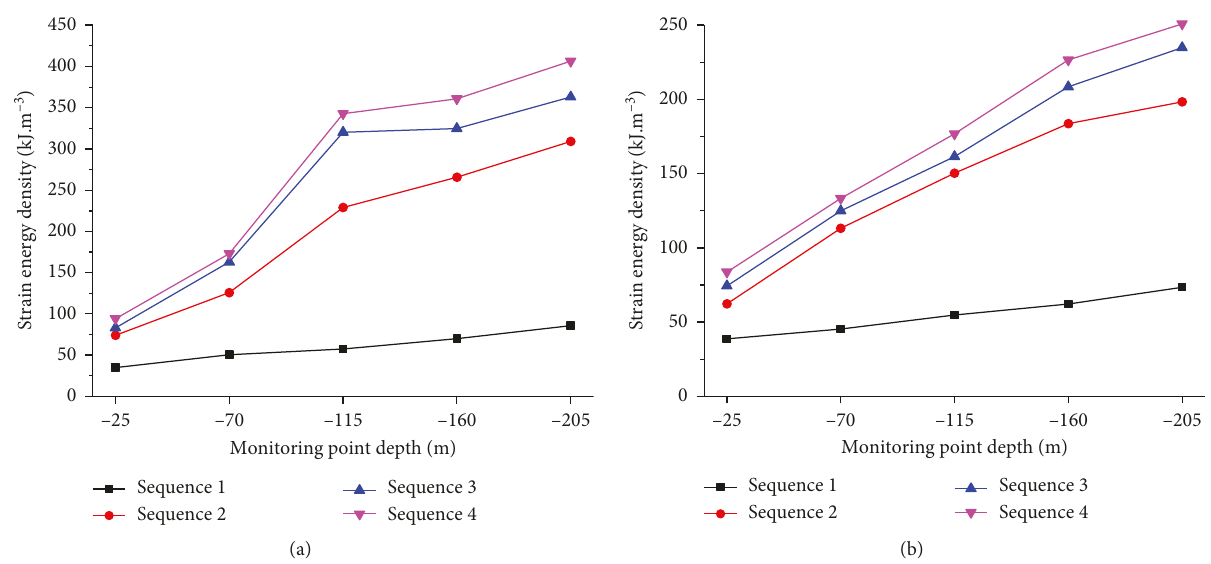
Figure 15: The maximum elastic strain energy evolution with depth. (a) Monitoring line 1. (b) Monitoring line